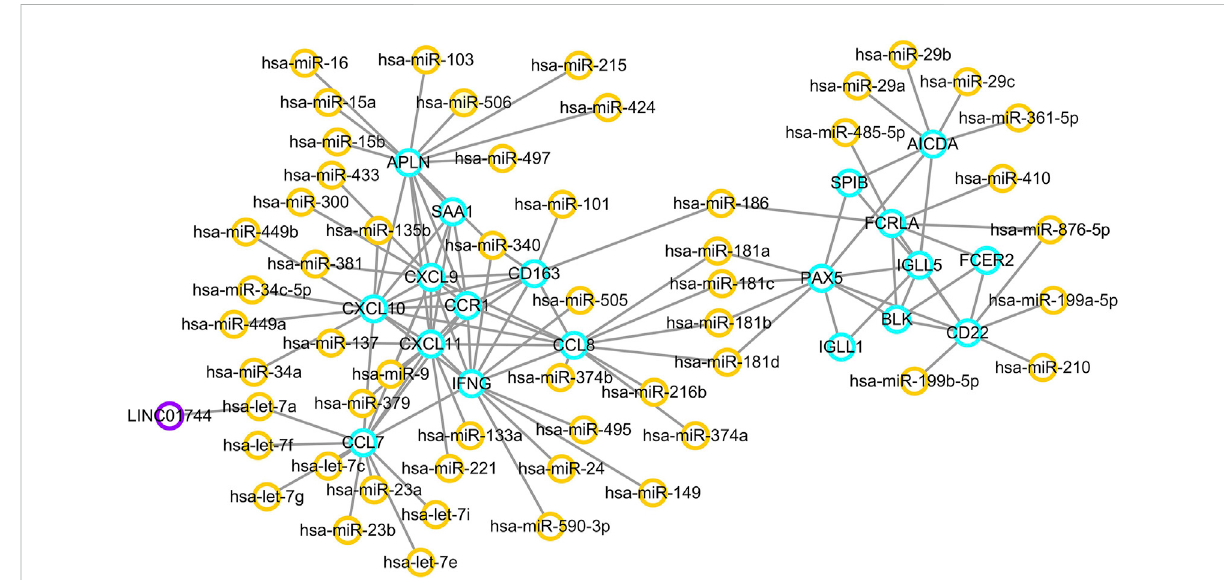
FIGURE 6 ceRNA regulatory network. Orange circles re fl ect miRNAs, and purple circles represent lncRNAs. Target genes are labeled in blue circles.